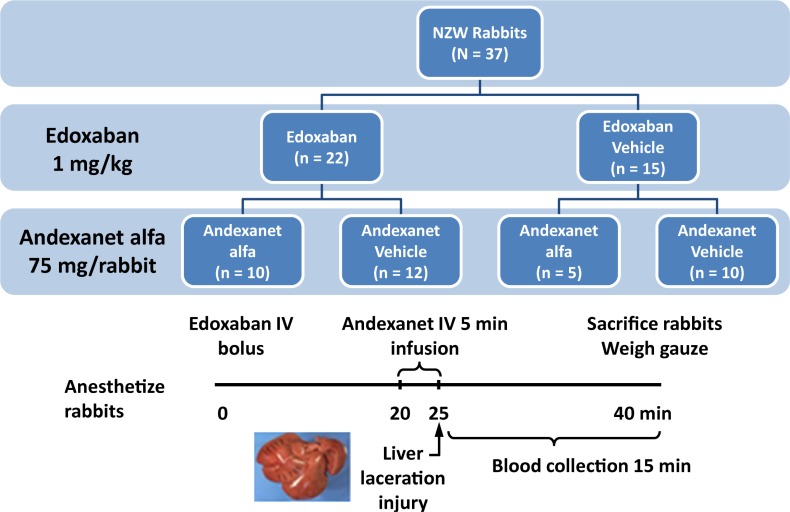
Design of rabbit liver laceration model of acute hemorrhage study.